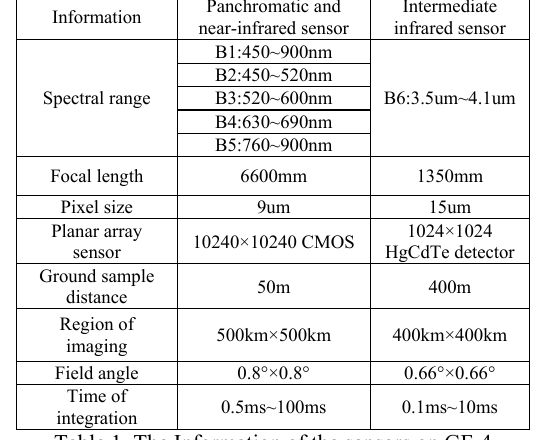
Table 1. The Information of the sensors on